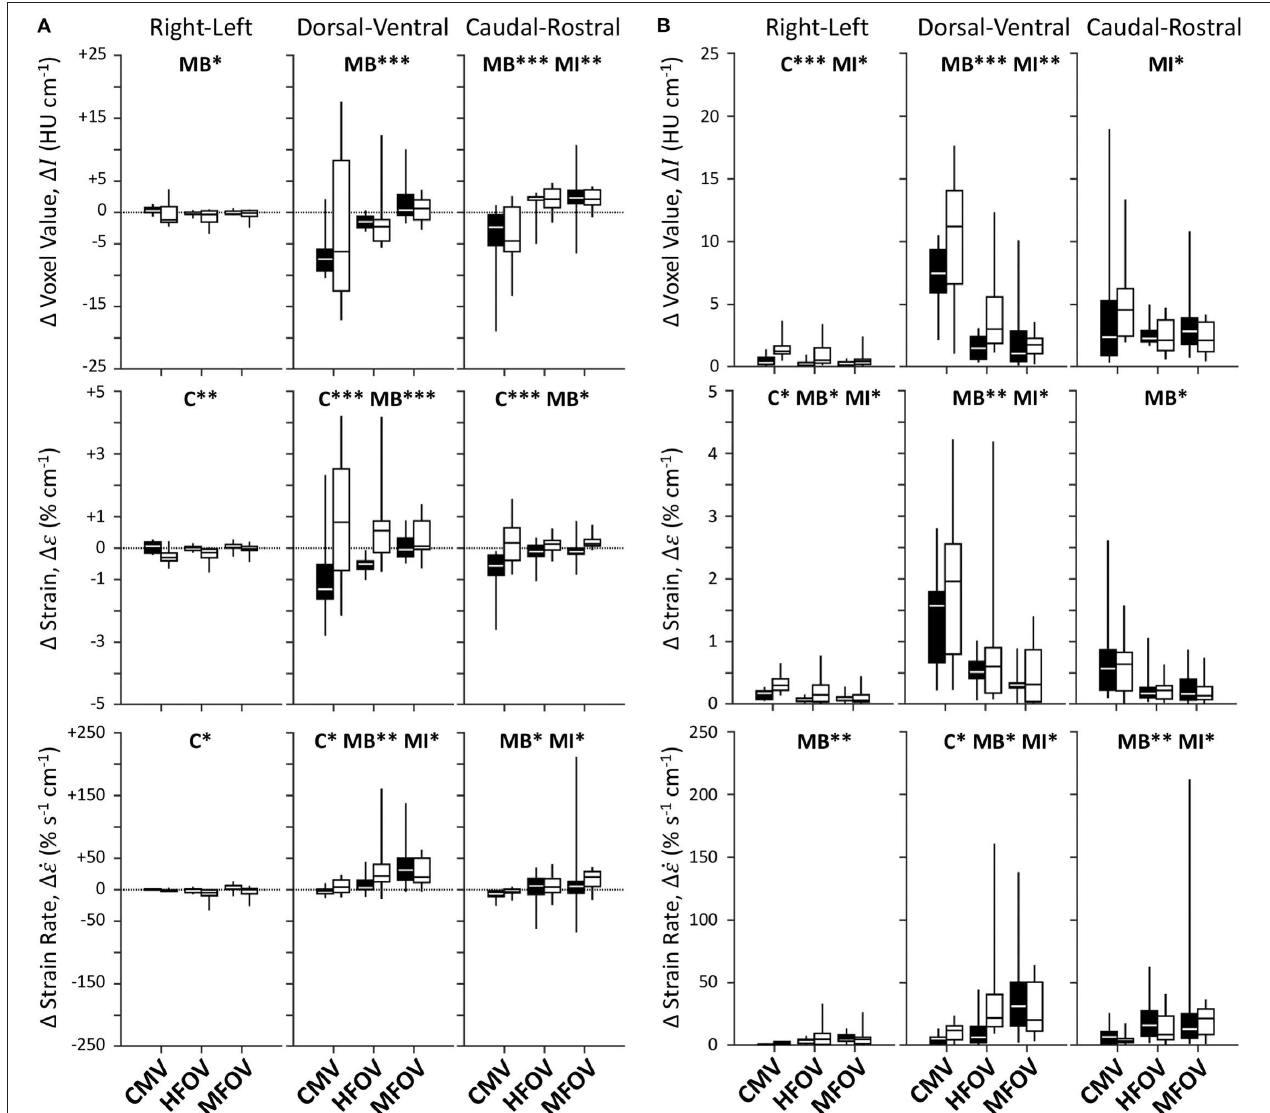
FIGURE 7 | Unnormalized spatial gradient values (A) and magnitudes (B) for image registration-based regional ventilation measures of intratidal changes in aeration ε ). Linear spatial gradients in each of the three principal anatomic directions throughout the lung mask are ( 1 I ), volumetric strain ( 1ε ), and volumetric strain rate ( 1 ˙ shown for each variable, represented by box plots showing minimum, maximum, and quartiles across subjects under baseline (black) and injured (white) conditions, during conventional mechanical ventilation (CMV), high-frequency oscillatory ventilation (HFOV), and multi-frequency oscillatory ventilation (MFOV). Asterisks indicate significance levels (* p < 0.05, ** p < 0.01, *** p < 0.001) for main effects (C lung condition, MB modality for baseline condition, MI modality for injured = = = condition). See Table 2 for additional